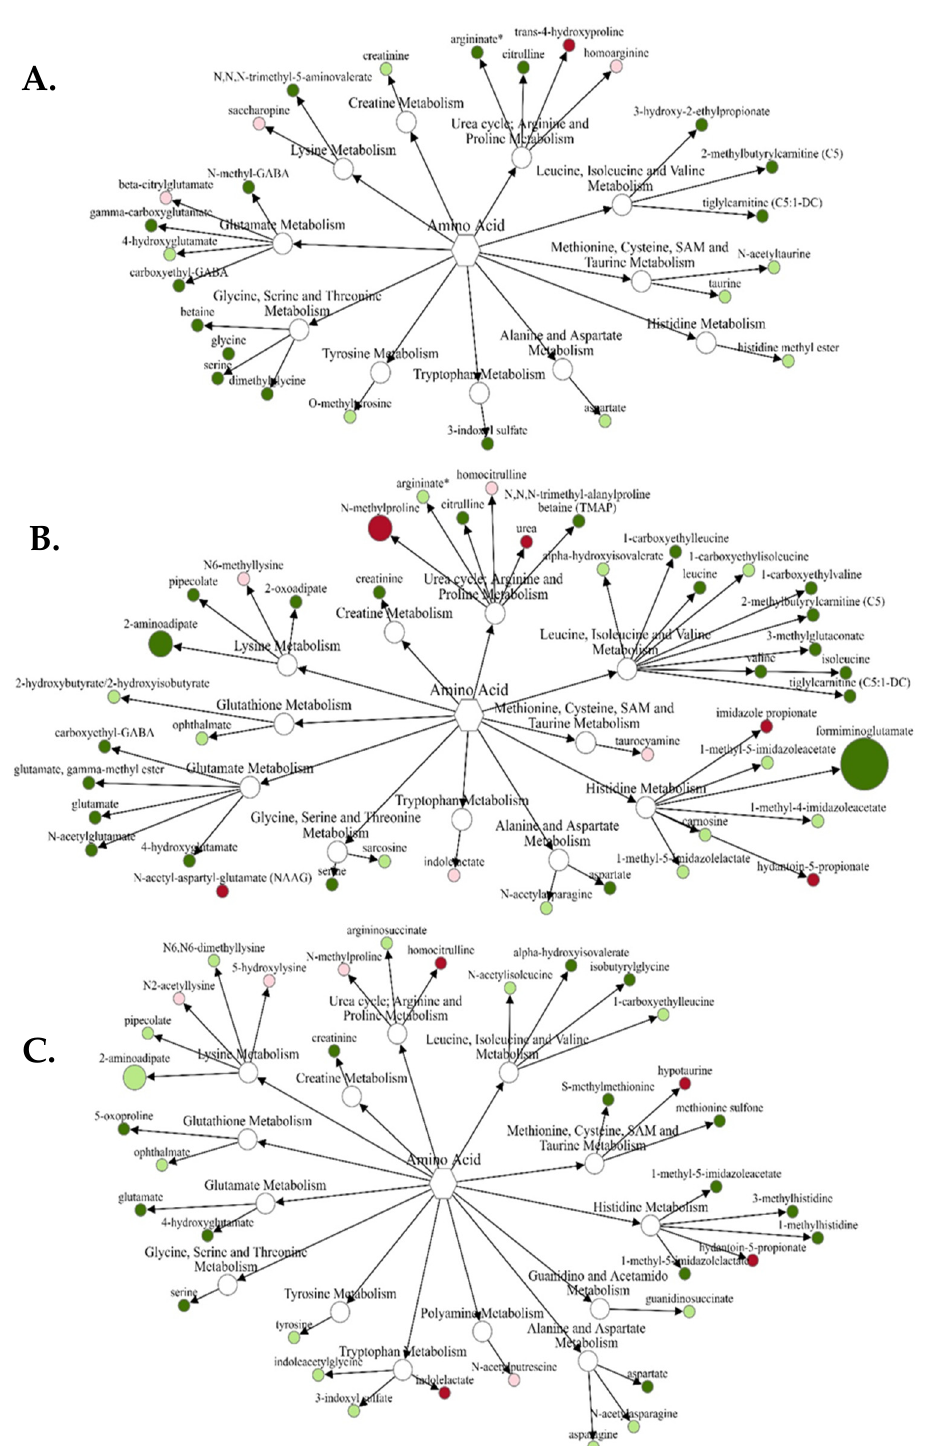
Figure 1. Network comparison of amino acid metabolites relative flux in fetal liver of VTM-LG vs. NOVTM-LG ( A ), NOVTM-MG vs. NOVTM-LG ( B ), and VTM-MG vs. NOVTM-LG ( C ). VTM = supplemented with vitamin/mineral. NOVTM = not supplemented with vitamin/mineral. LG = fed to gain 0.28 kg/day. MG = fed to gain 0.79 kg/day. Node diameter is proportional to the fold-change observed. Node color represented the significance of the change: dark red is an increase ( p ≤ 0.05), light red is a tendency to increase (0.05 < p ≤ 0.10), dark green is a decrease ( p ≤ 0.05), and light green is a tendency to decrease (0.05 < p ≤ 0.10). Only significant biochemicals are